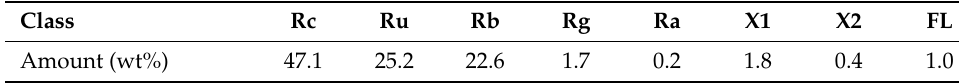
Table 2. Composition of MRA as per standard EN 12620.